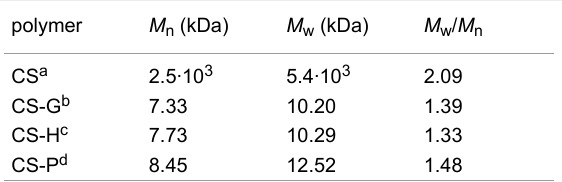
Table 1: Number-average ( M n ) and weight-average ( M w ) molecular mass of chitosan before and after free-radical grafting with various phenolic